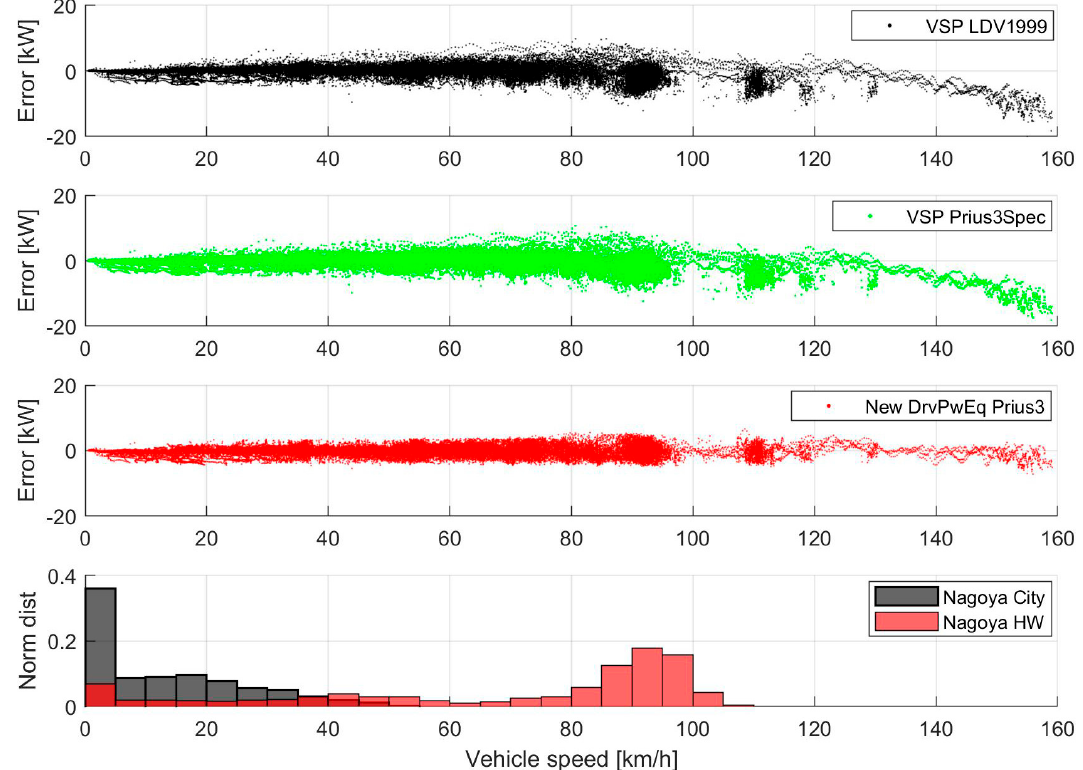
Figure 8. Driving-power-prediction error analysis on impact of driving speed on prediction errors from VSP LDV 1999, VSP Prius3Spec, and DrvPw Prius 3 .